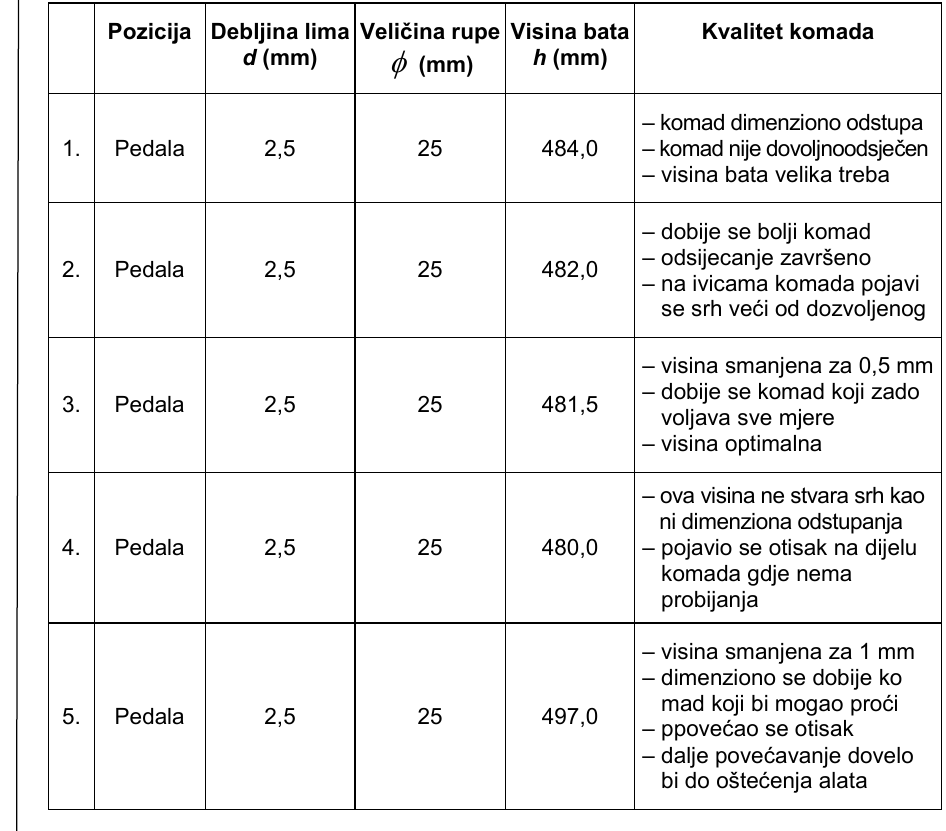
Iz tabele1 može se vidjeti da je optimalna vrijednost visine bata 449,6 mm. Za ovu poziciju nemamo neku veliku mogu ć nost smanjivanja visine bata u odnosu na ovu koja se pokazala kao optimalna, zbog toga što je debljina lima prili č no mala za ovaj tip prese, tako da se mala pro- mjena visine znatno odrazi na komad. Dalje pove ć anje visine nema efek- ta, jer ve ć na visini od 453 mm nema dovoljnog probijanja i odsijecanja, tako da je dalje pove ć avanje nepotrebno.